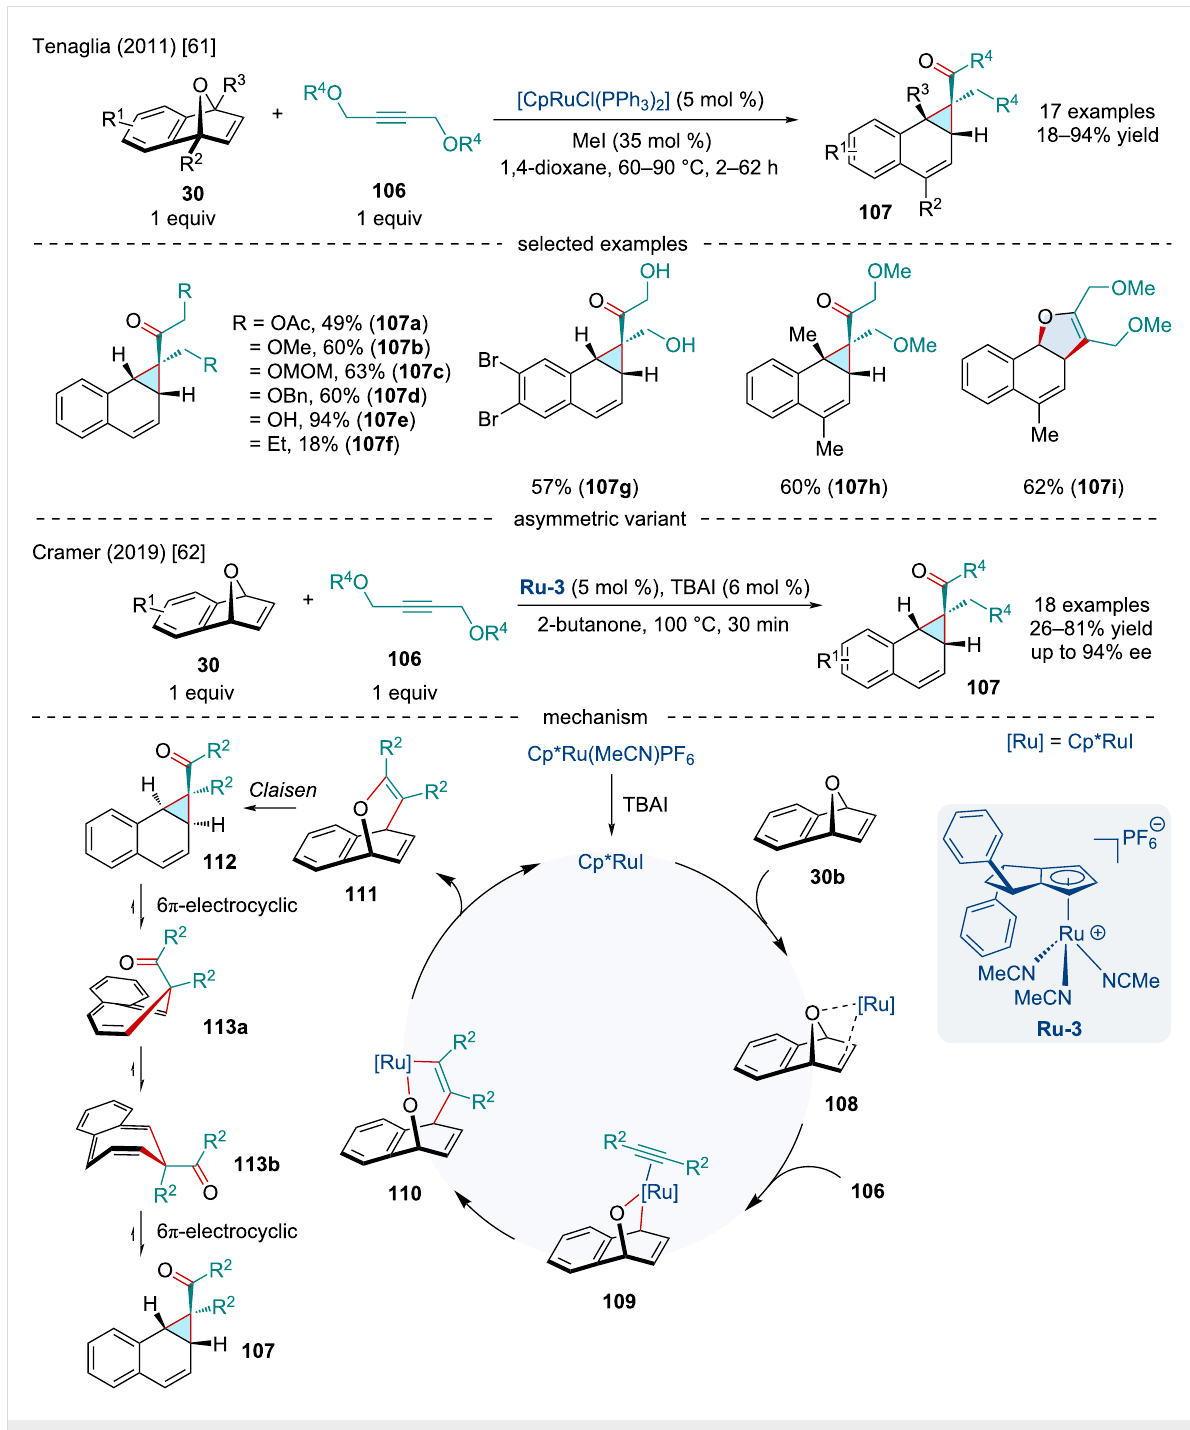
the dehydrative naphthylation sequence did not occur with the reaction being exclusive for exo -ring-opened products, similar to that observed in a typical Rh-catalyzed ring-opening reaction (vide infra). The reaction seems to be sensitive to the steric bulk